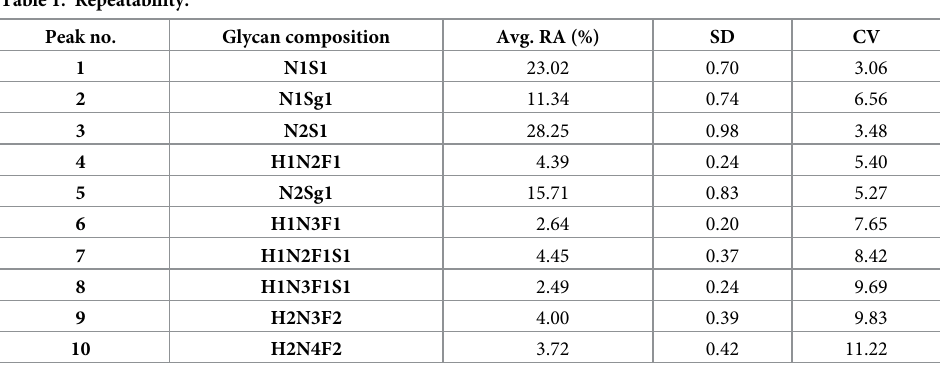
Glycan composition, average relative areas (Avg. RAs), standard deviations (SDs) and coefficients of variation (CVs) for ten representative O -glycan structures calculated after triplicate